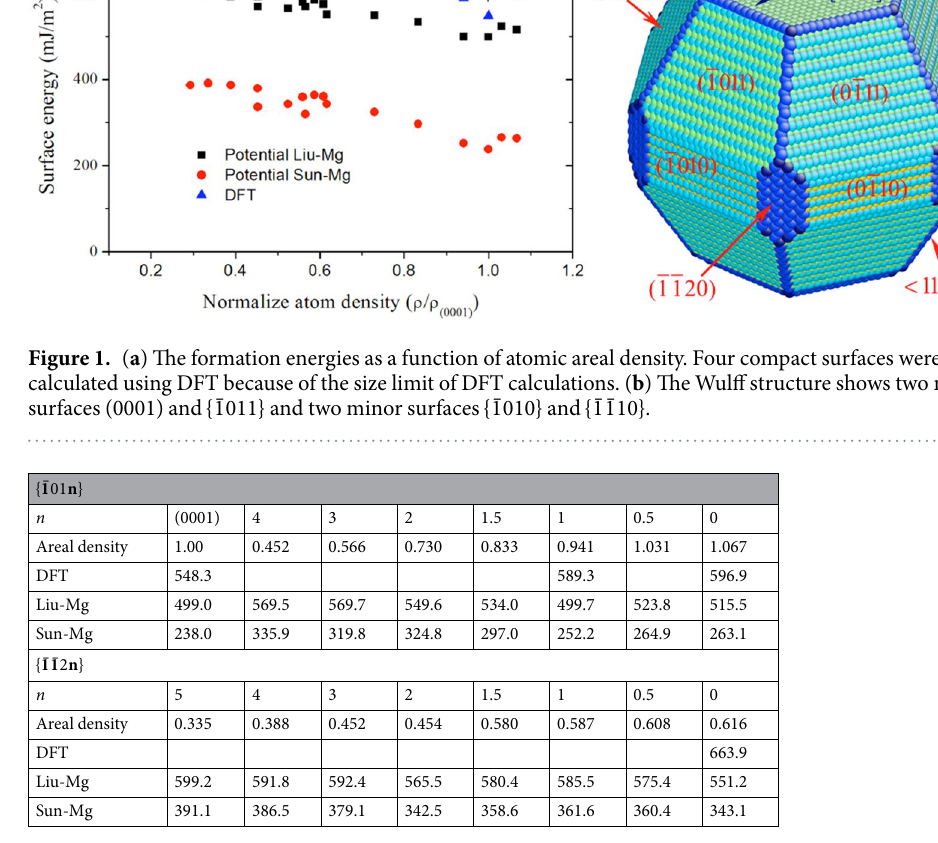
Table 1. Surface formation energy (mJ/m 2 ). Areal density denotes the normalized atomic areal density ρ / ρ {0001}